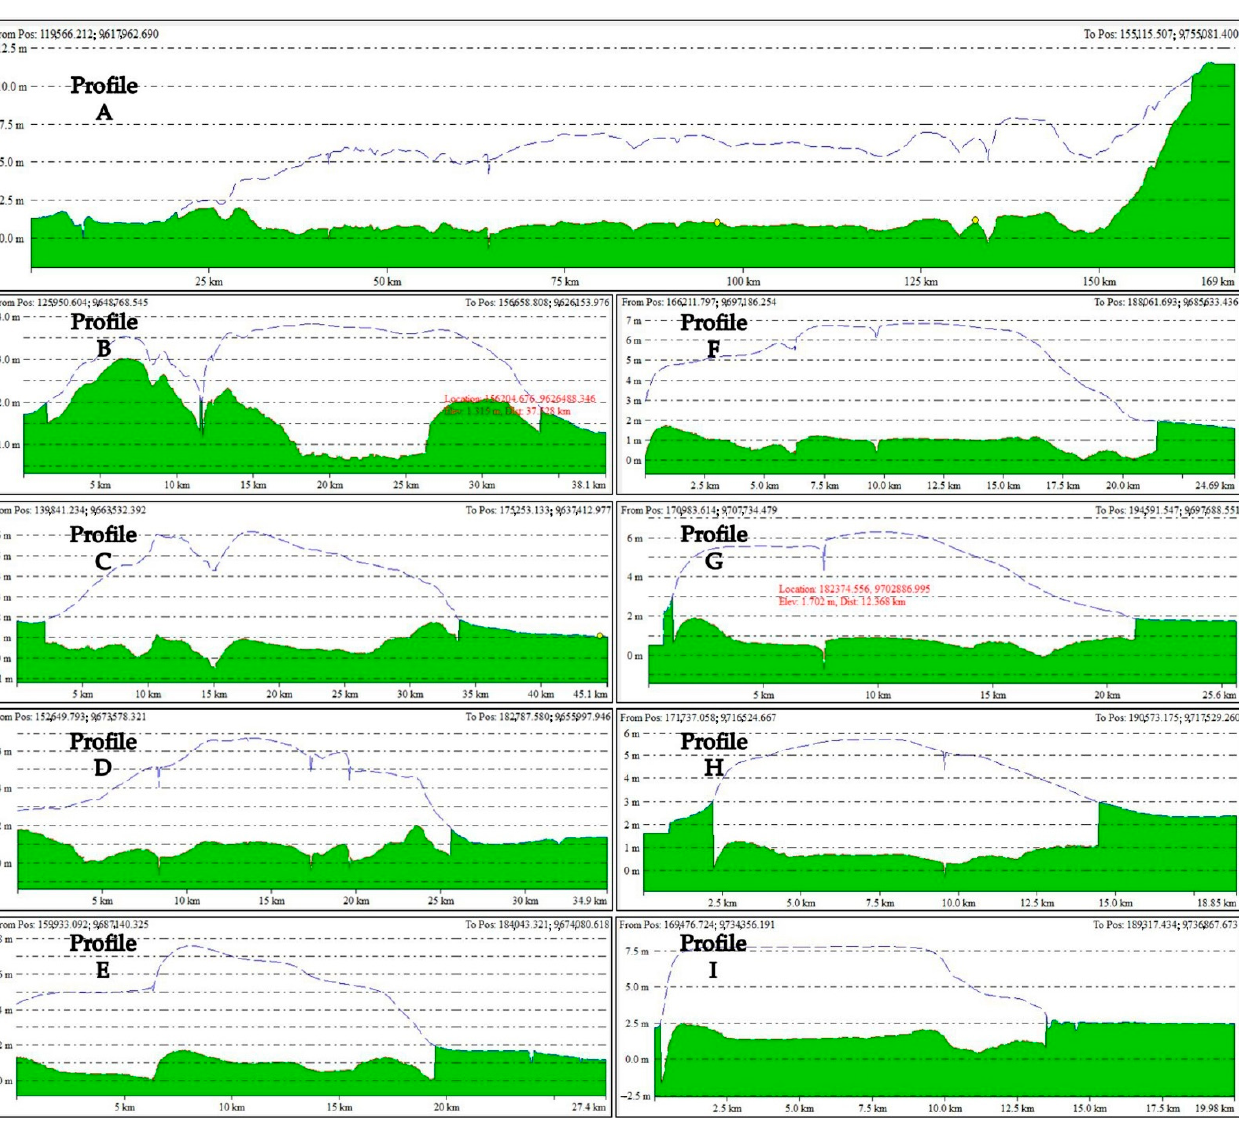
Figure A1. The visualization of peat soil thickness in cross-profiles in the Kahayan–Sebangau PHU consider the topographic position of the soil surface (blue dashed-line) and mineral soil elevation (green). (data source: BRGM-RI; processed by the authors).